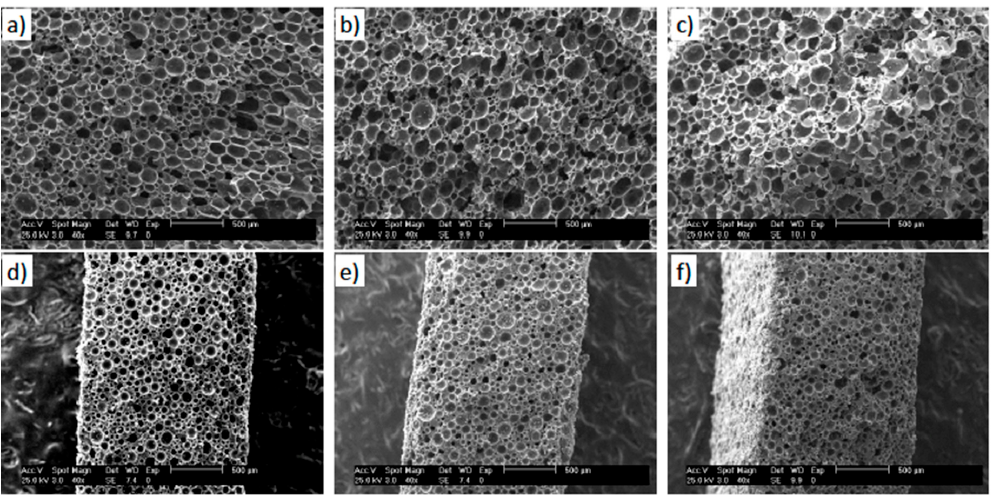
Figure 3. SEM images of the foams. ( a ) Neat ER-LD, ( b ) 0.5 wt.% MWCNT-LD, ( c ) 1.5 wt.% TRGO-LD, ( d ) neat ER-HD, ( e ) 0.5 wt.% MWCNT-HD, and ( f ) 1.5 wt.% TRGO-HD.